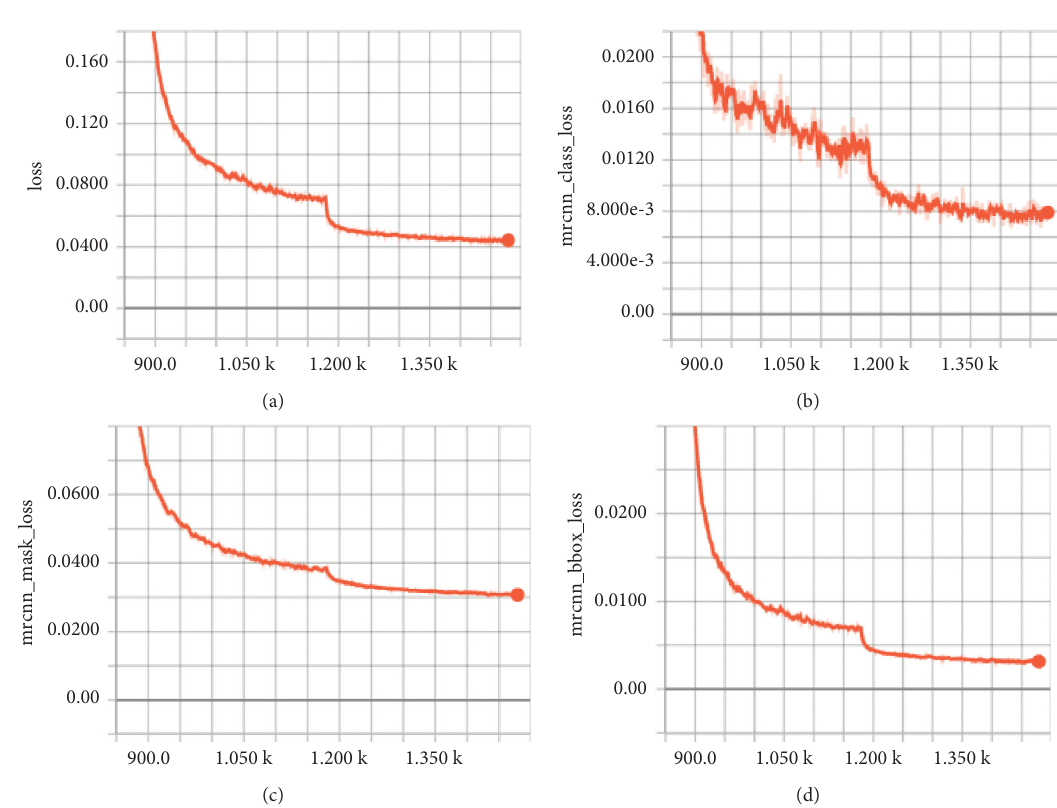
Figure 14: Plot of the loss functions: (a) loss; (b) class_loss; (c) mask_loss; (d)